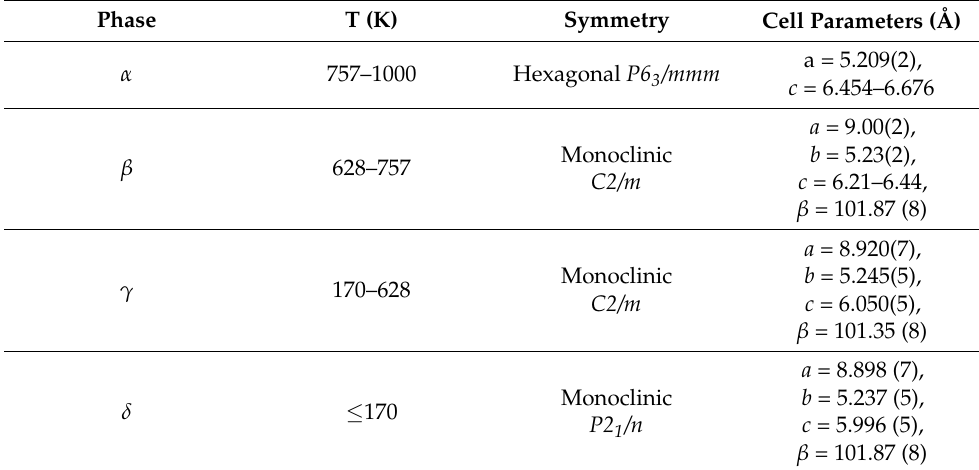
Table 3. Sodium carbonate (Na 2 CO 3 ) phase transitions in the temperature range investigated. Crystallographic data are taken from Dusek et al. [68], Arakcheeva et al. [69], Arakcheeva et al. [70], Swainson et al. [71]. T (K) are phases stability temperatures ranges.